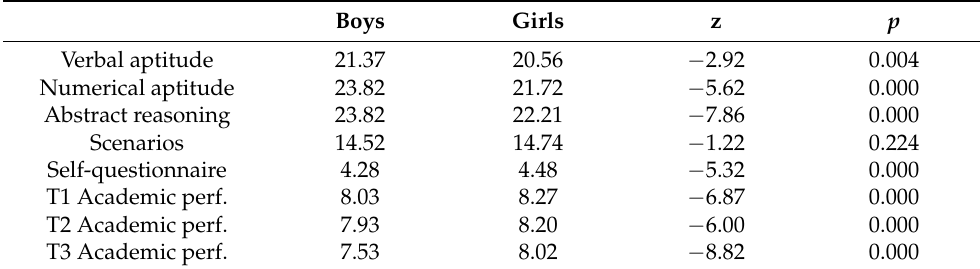
Table 2. Gender among variables under study.